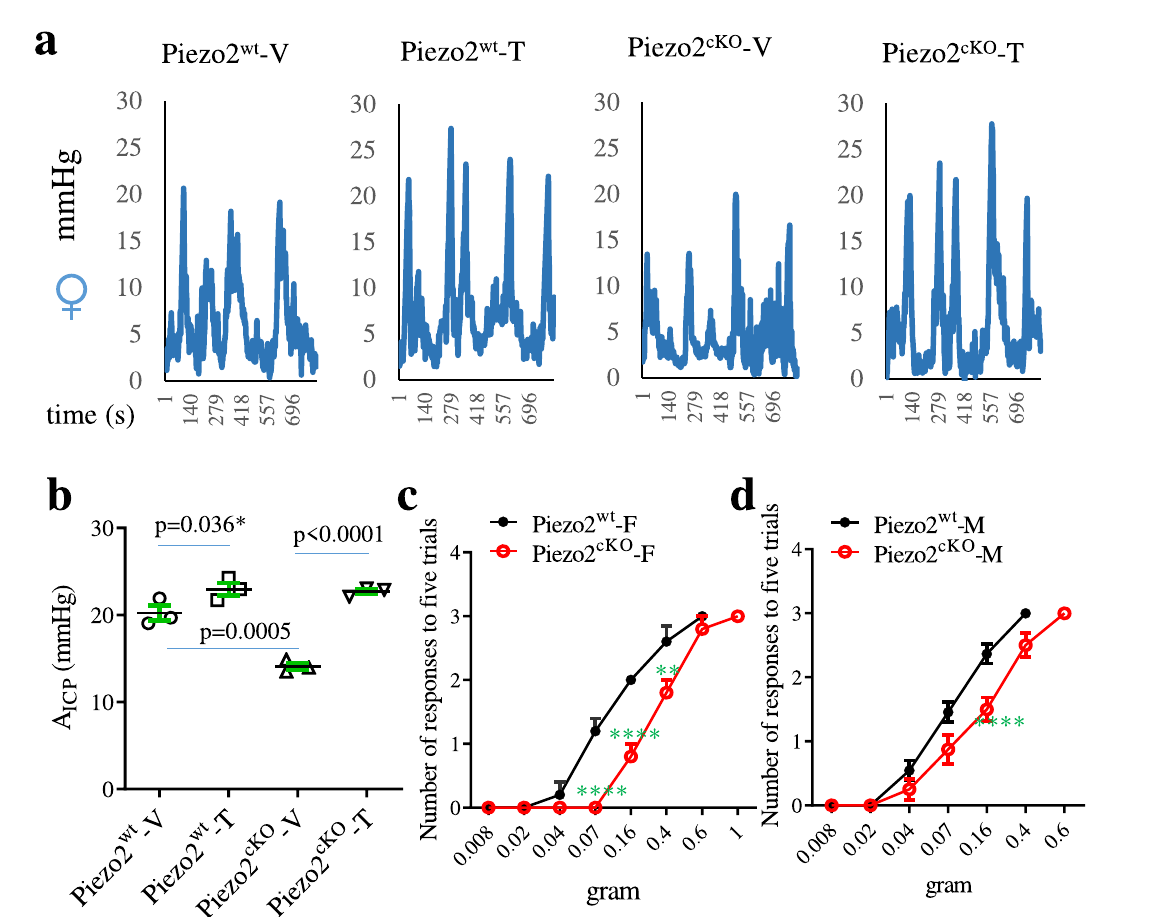
Fig. 8 | Effects of Piezo2 conditional deletion on female colonic pain hyper- sensitivity. a Piezo2 wt and Piezo2 cKO female mice that receive either vehicle (V) or 2,4,6-Trinitrobenzenesulfonicacid(T:TNBS)aresubjecttocolonometricalanalysis on day 7 post drug treatment. b Average of amplitude of intracolonic pressures (A ICP ) from each animal are analyzed. n =3 biologically independent mice for all groups. Data are presented as mean values+/- SEM. One-way ANOVA with Tukey ’ s multiplecomparisonstest(Piezo2 wt -VvsPiezo2 wt -T: p =0.055,*One-tailedunpaired t test: p =0.0364, t =2.42; Piezo2 wt -V vs Piezo2 cKO -V: p =0.0005; Piezo2 cKO -V